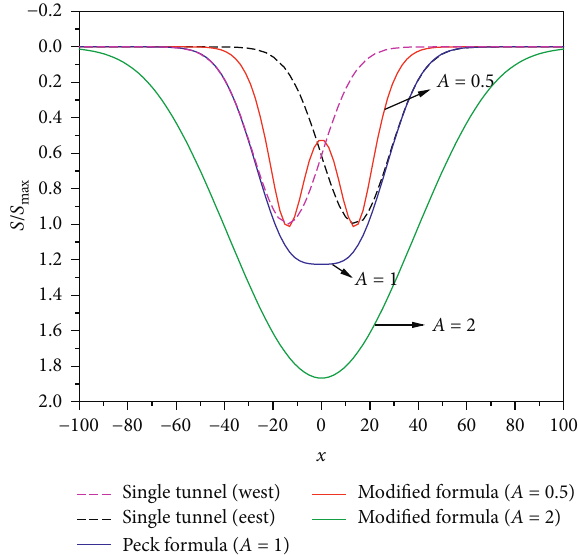
Figure 3: Influence of (A) on settlement trough of twin